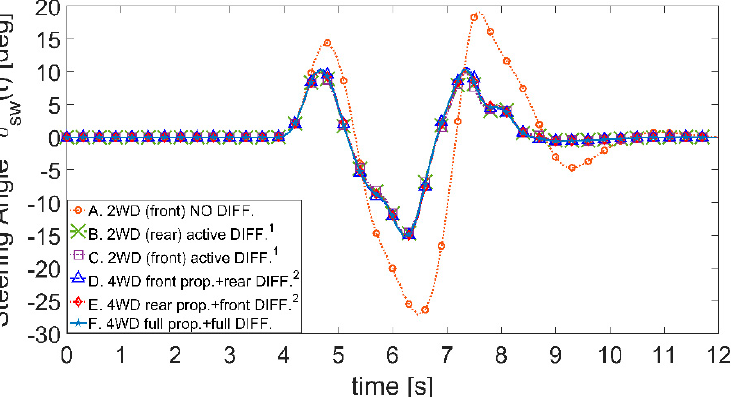
→ → d ( b ) },C{ d ( g ) }) → → d ( d ( }; B. 2WD (rear) active DIFF.{ }; C. 2WD (front) e ) b ) → d ( }; E. 4WD rear prop.+front DIFF. f ) → d ( }. The vehicle is cruising at 120 [km/h] on l )